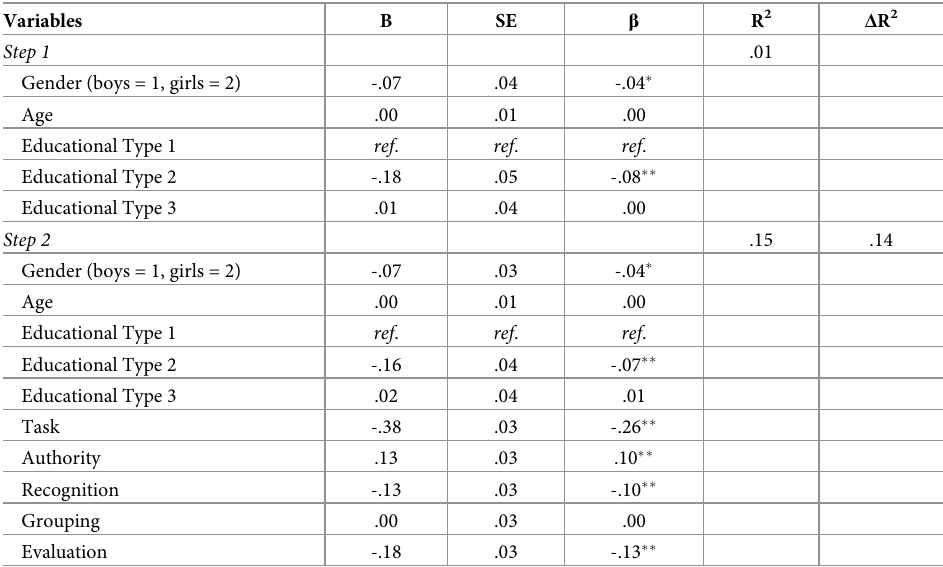
Table 4. Summary of hierarchical regression analysis for variables predicting amotivation.